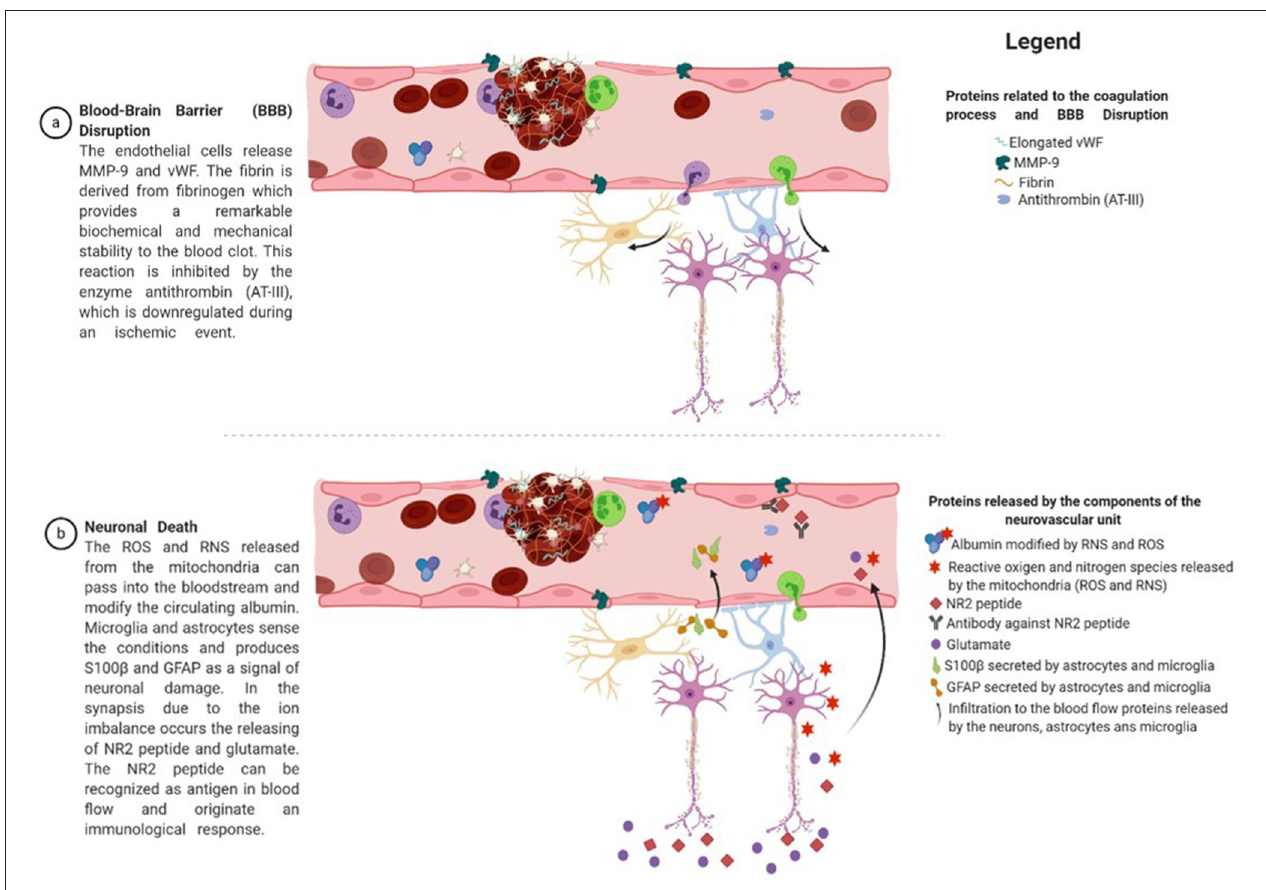
FIGURE 4 | Proteins derived from the proposed panel of biomarkers and their relation to the pathophysiology of stroke. After an injury, endothelial cells release MMP-9, which plays an essential role in the extracellular matrix and local proteolysis of leukocyte migration. In addition, endothelial cells release vWF in a globular form, which is then transformed into an elongated form by the activity of the ADAMTS13 enzyme. vWF promotes platelet adhesion to the damaged site by forming a molecular bridge between the subendothelial collagen matrix and the platelet-surface receptor complex GPIb-IX-V. Fibrinogen is released from the liver to the bloodstream and is cleaved by thrombin at the damaged site, resulting in fibrin formation. Fibrin is one of the main constituents of blood clots and provides remarkable biochemical and mechanical stability. The conversion of fibrinogen to fibrin by thrombin is inhibited by the enzyme antithrombin (AT-III), which is downregulated during an ischemic event. In addition, neutrophils and leukocytes arrive at the injured site and join with the previous proteins to form a solid structure that obstructs or reduces blood flow. These conditions lead to a shift in the neuron’s metabolic conditions, mitochondrial dysfunction, excitotoxicity, and ion imbalance. The reactive oxygen and nitrogen species released from the mitochondria can pass into the bloodstream and modify the circulating albumin. On the other hand, microglia and astrocytes sense the conditions and produce S100 β and GFAP to signal neuronal damage. In synapsis, because of ion imbalance, the release of the NR2 peptide and glutamate occurs. The NR2 peptide can be recognized as an antigen in the blood flow and induces an immunological response. Figure was drawn using